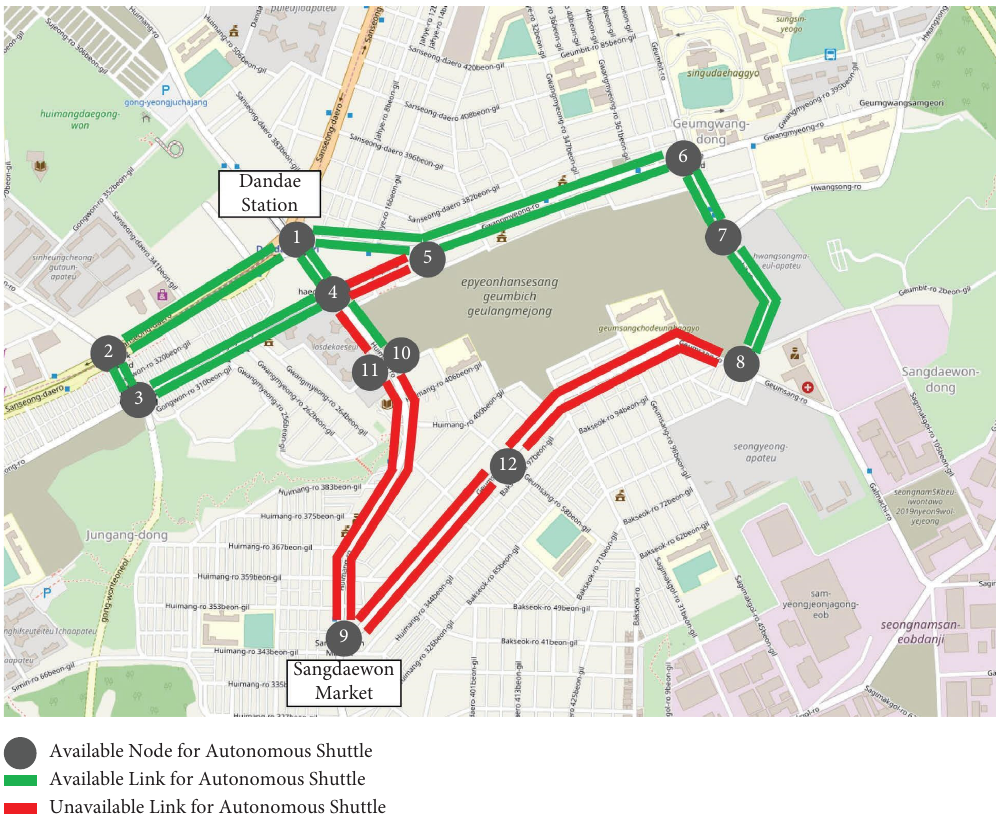
Figure 22: Result of autonomous shuttle operation feasibility analysis based on ODD for < traditional market > major